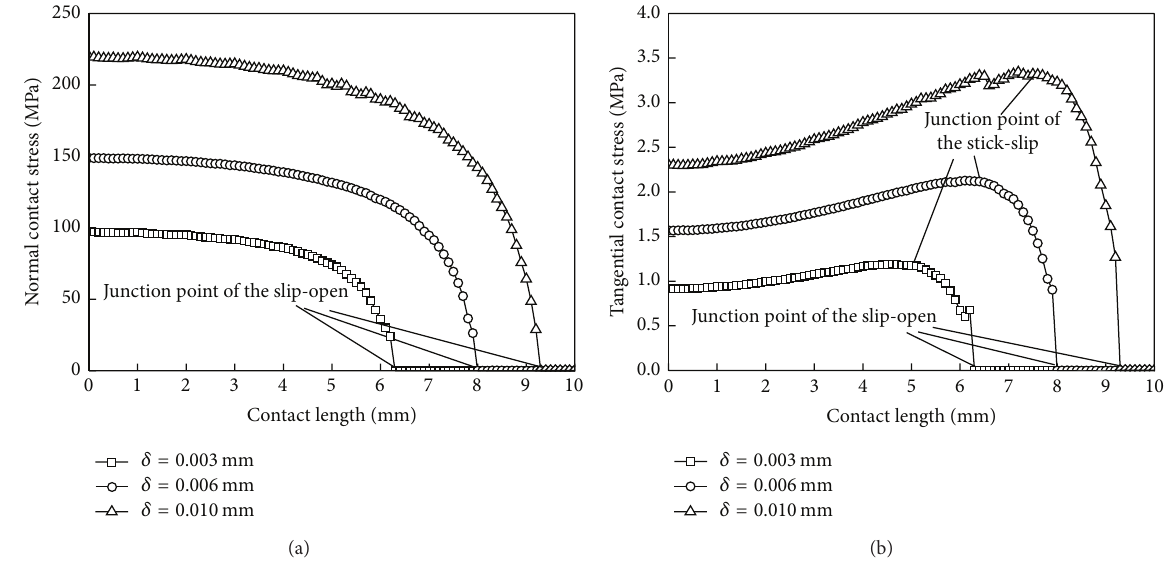
Figure 11: Contact stress distribution curves under different magnitudes of interference. (a) Normal contact stress and (b) tangential contact stress.